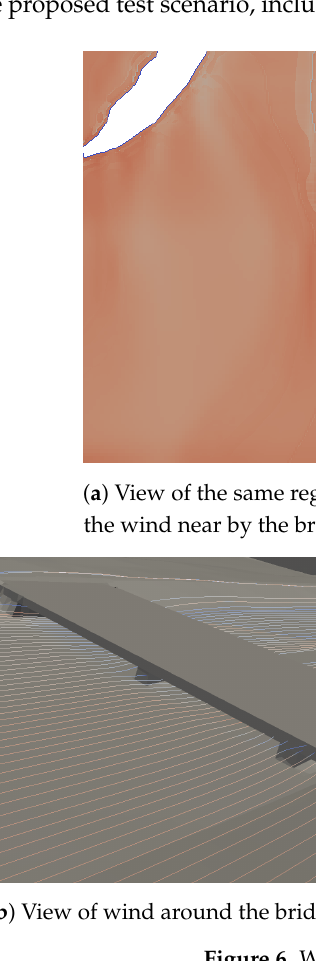
Figure 6. Wind simulation within